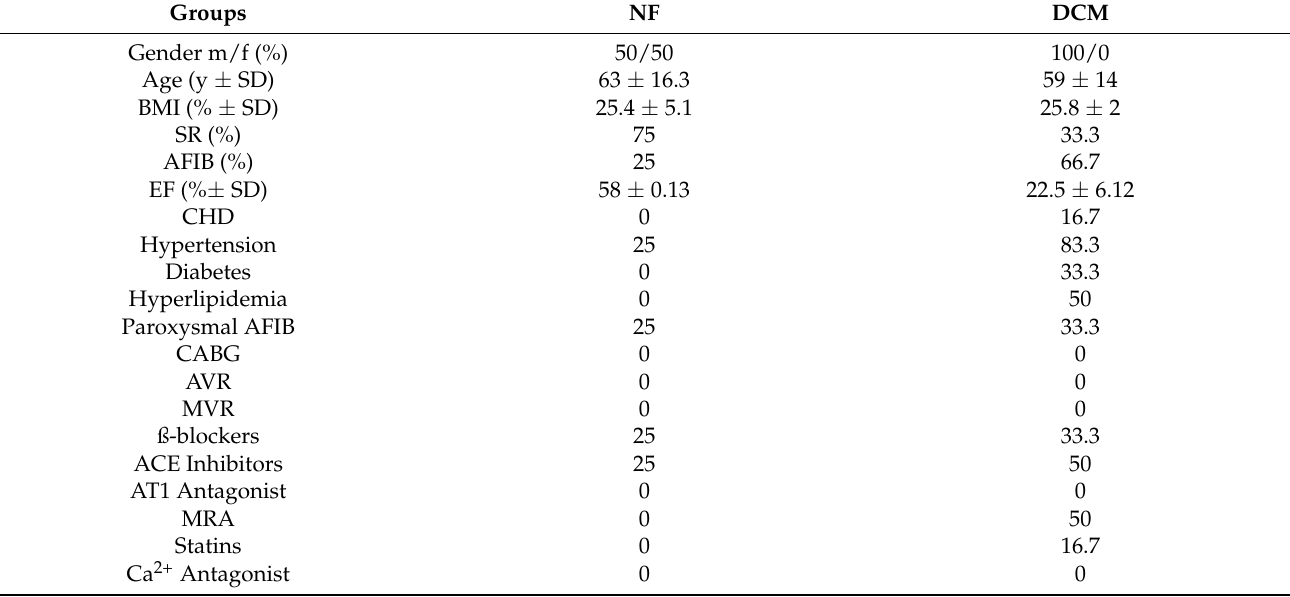
Table 3. Baseline characteristics of dilated cardiomyopathy (DCM) and non-failing (NF) ventricle